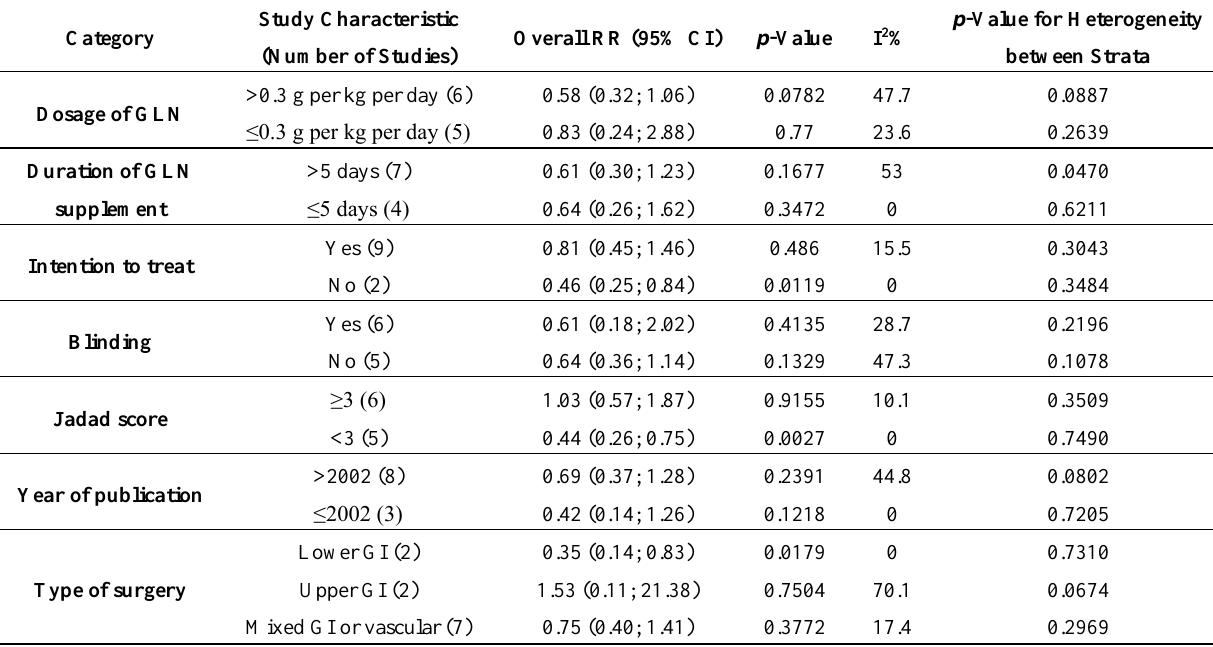
Table 3. Stratified analysis for infectious morbidity comparing GLN vs. control.